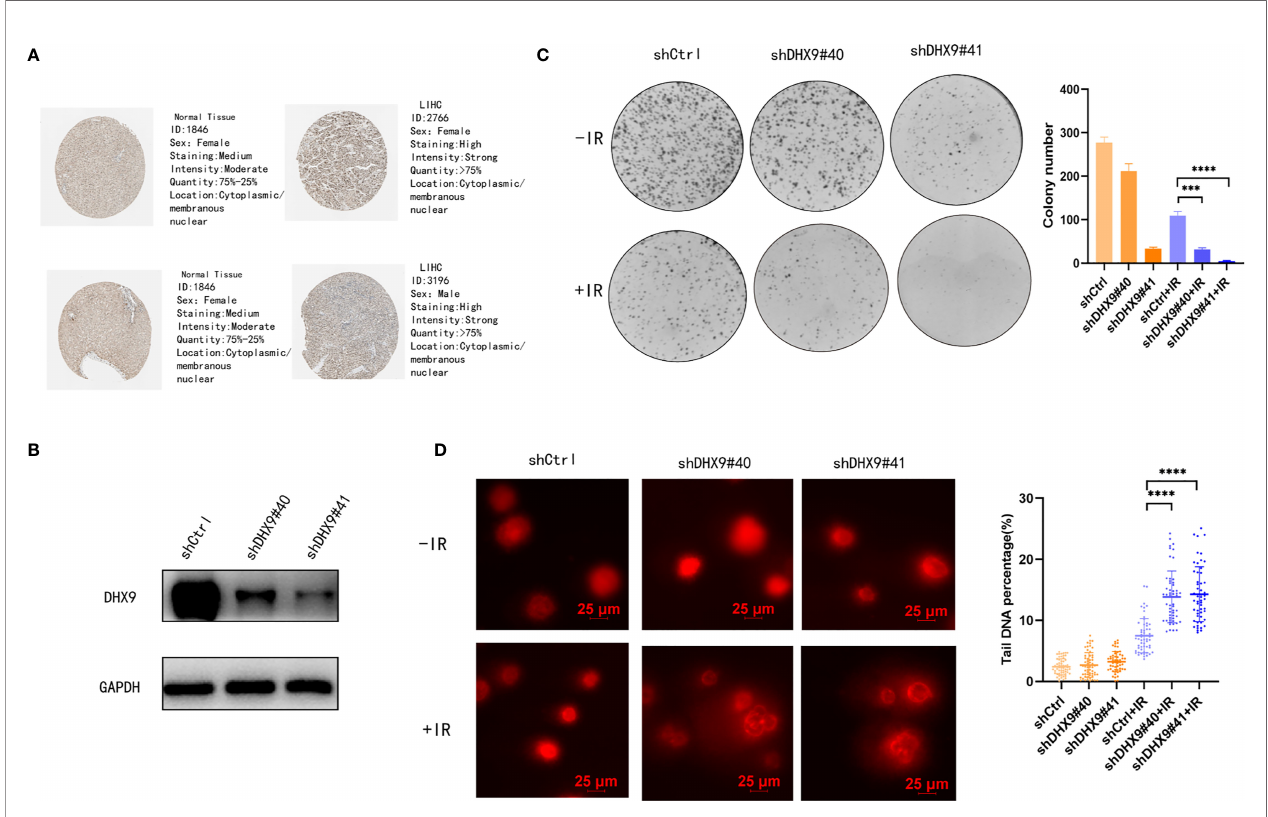
FIGURE 6 | Role of DHX9 in radiosensitivity of Hep-3B cells. (A) Immunohistochemistry of DHX9 protein in normal and tumor tissues from the HPA database. (B) Western blot analysis of DHX9 expression in Hep-3B cells after stable transfection using lentivirus. (C) Representative images of the colony formation assay using Hep-3B cells and quanti fi cation of the colonies. (D) Representative images of DNA comets using Hep-3B cells (scale bar: 25 m m) and quanti fi cation of the DNA percentage of the comet tail (n>50 nuclei per sample). The data are presented as the mean ± standard deviation. Two-tailed, unpaired Student ’ s t -test was performed for statistical analysis. *** p < 0.001; **** p <